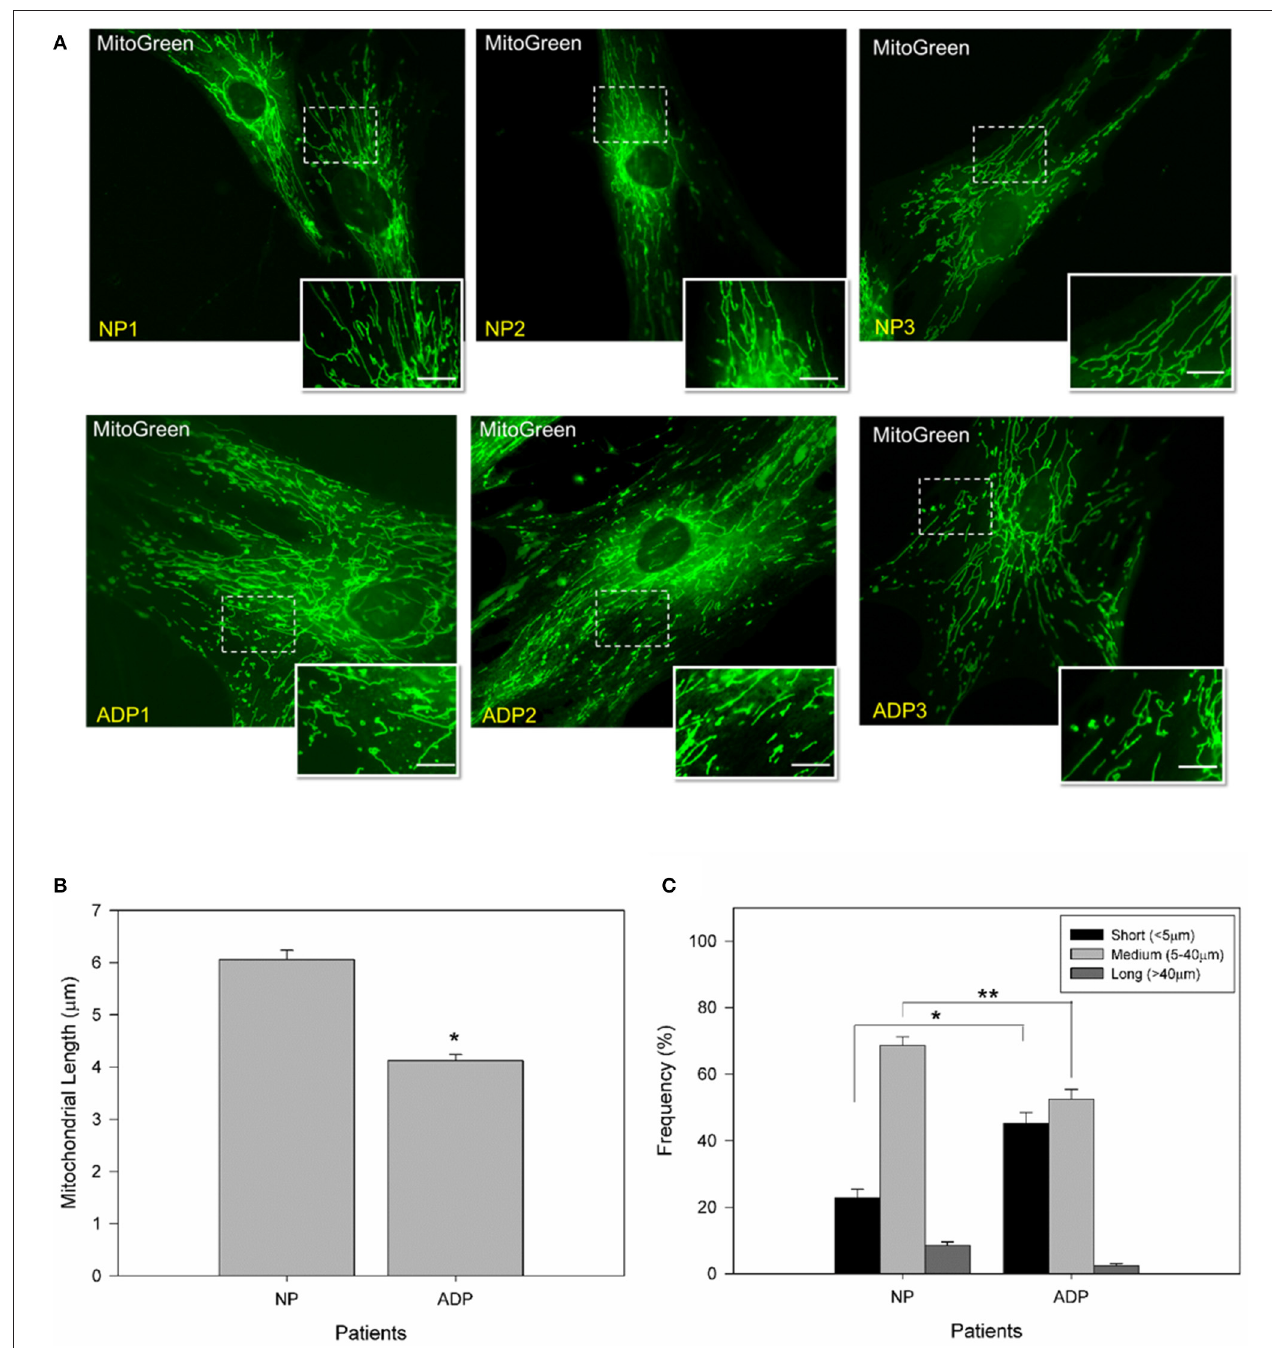
FIGURE 1 | AD cultured fibroblasts present a decrease in mitochondrial length. (A) Cells were loaded with MitoGreen to determinate mitochondrial morphology. Bar = 10 µ m. (B) Quantification of the mitochondrial length average obtained from microscopy analysis (see Methods). Data are mean ± SE , n = 3 (technical replicates for each subject). * p < 0.001 indicate differences between groups calculated by Student t -test. (C) Distribution of mitochondrial length in cultured fibroblasts from AD and control patients. Mitochondrial lengths were grouped in short, medium and long size. Data are mean ± SE, n = 3 (technical replicates for each subject). * p < 0.005, ** p < 0.003 indicates differences between groups calculated by Student t -test between short, medium and long mitochondria from AD and control patients.